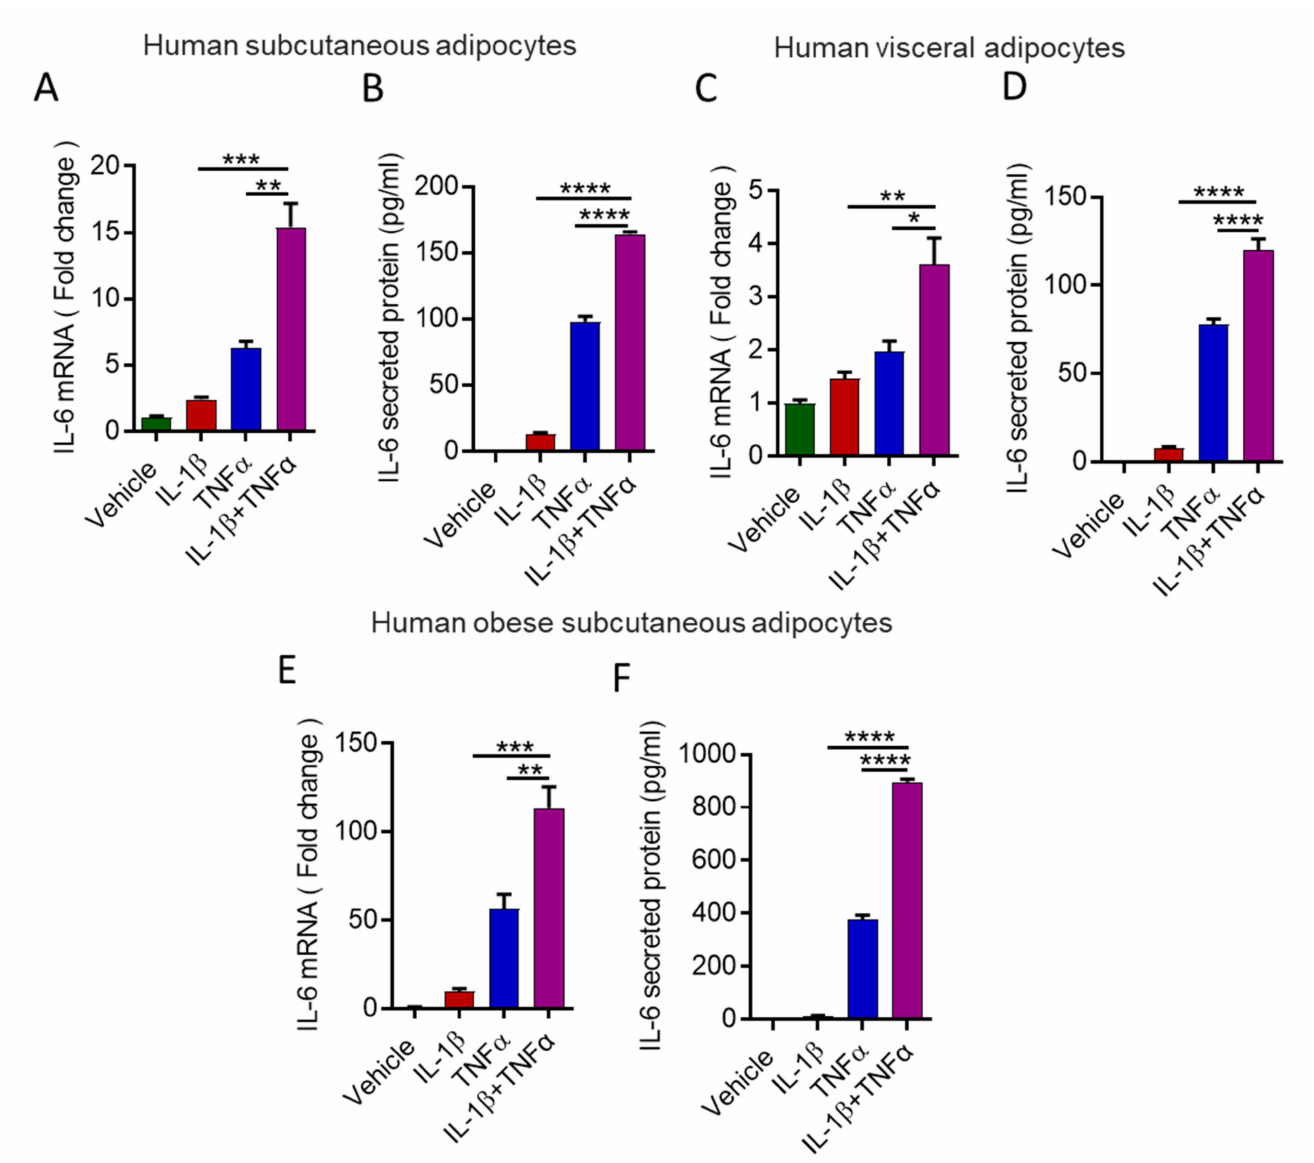
Figure 2. Combined effect of IL-1 β and TNF α on IL-6 expression in human adipocytes. Human primary subcutaneous adipocytes were stimulated with IL-1 β (250 pg/mL) and TNF α (250 pg/mL) alone or in combination. Cells and culture media were collected. ( A ) Total RNA was extracted from the cells and IL-6 mRNA was quantified by real time PCR. Relative mRNA expression was expressed as a fold change. ( B ) Secreted IL-6 protein in culture media was determined by ELISA. ( C , D ). Human primary visceral adipocytes were stimulated with IL-1 β and TNF α alone or in combination. Cells and culture media were collected, and IL-6 were determined. ( E , F ) Human primary adipocytes isolated from obese adipose tissue treated as described earlier. Cells and culture media were collected, and IL-6 was determined. Data are expressed as mean ± SEM ( n = 3). * p < 0.05, ** p < 0.01, *** p < 0.001, **** p <